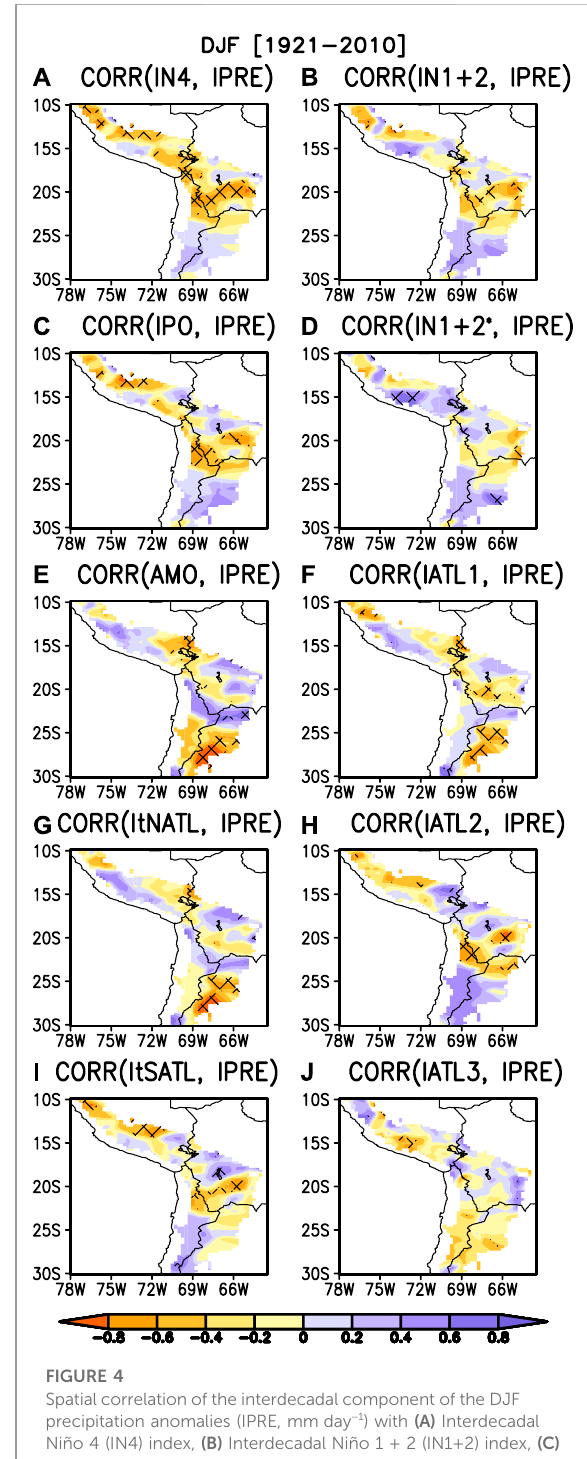
FIGURE 4 Spatial correlation of the interdecadal component of the DJF precipitation anomalies (IPRE, mm day − 1 ) with (A) Interdecadal Niño 4 (IN4) index, (B) Interdecadal Niño 1 + 2 (IN1+2) index, (C) Interdecadal Paci fi c Oscillation (IPO), (D) Interdecadal Niño 1 + 2 with Niño 4 removed (IN1+2*) index, (E) Atlantic Multidecadal Oscillation (AMO), (F) fi rst rotated principal component of the interdecadal variability of the Atlantic SST (IATL1), (G) Interdecadal tropical North Atlantic (ItNATL) index, (H) second rotated principal component of the interdecadal variability of the Atlantic SST (IATL1), (I) Interdecadal tropical South Atlantic (ItSATL) index, and ( Continued )